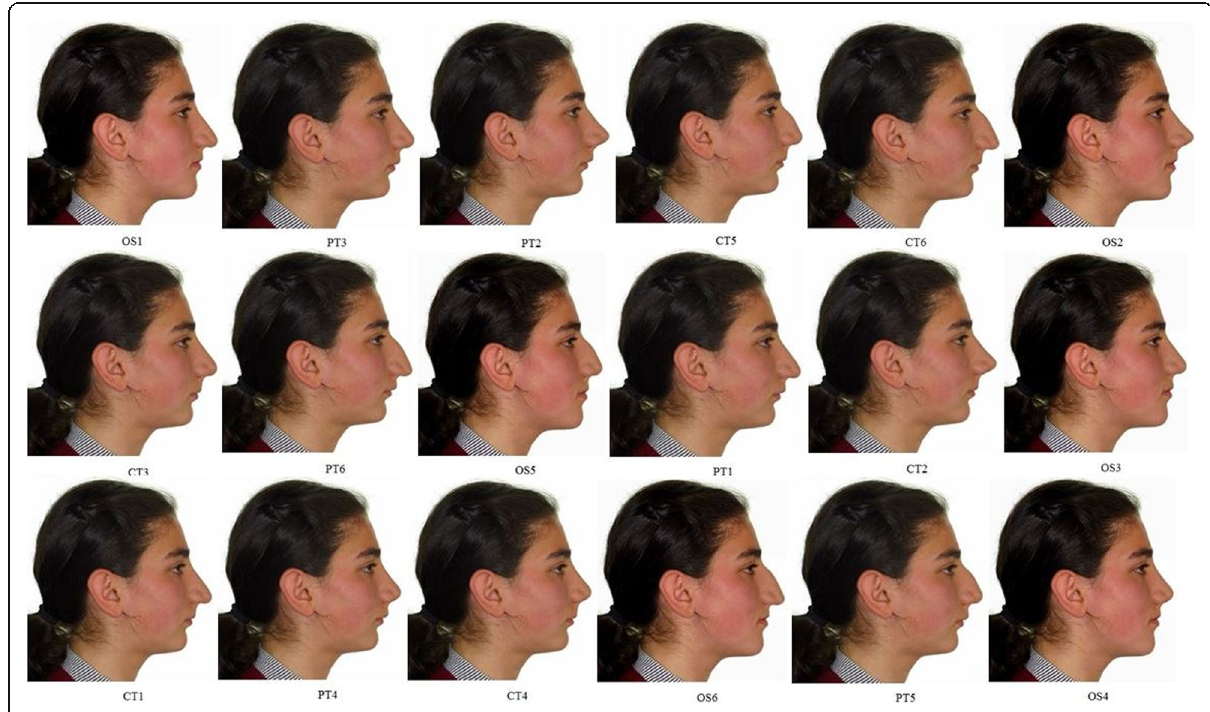
Fig. 5 The final version of the survey